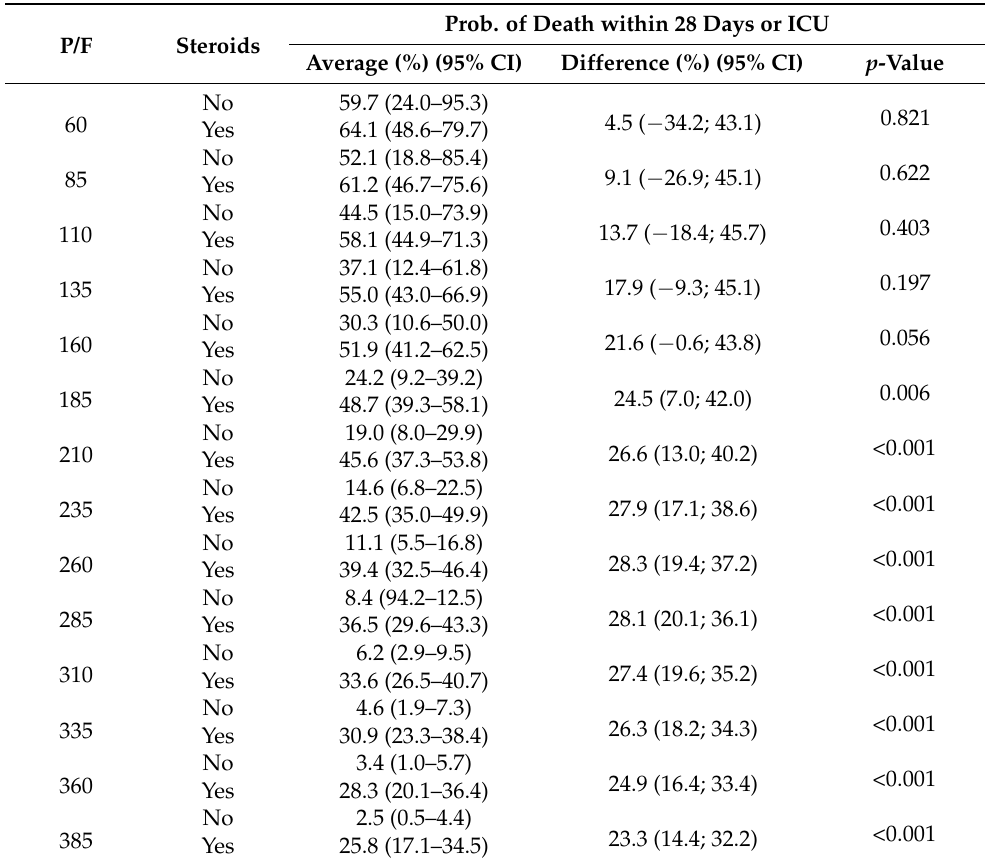
Table 5. Estimated margins of probability of death within 28 days or ICU with respect to P/F values for exposed and unexposed cohorts. Difference column explains the steroid